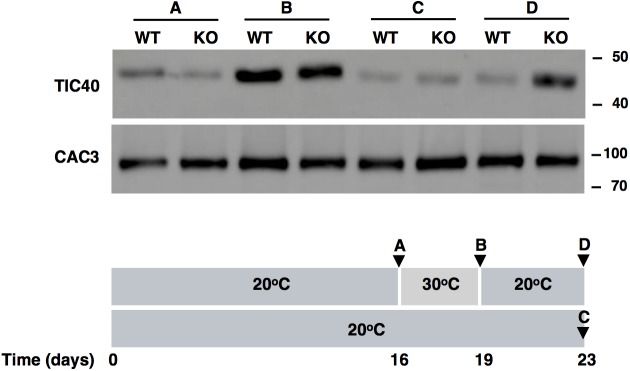
TIC40 is stabilized in the FTSH11 KO mutant upon recovery from heat. Two weeks old seedlings were grown at 20°C for additional 16 days, before being transferred to 30°C for 3 days and then returned to recovery at 20°C for 4 days. A control group was kept at 20°C for the entire duration of the experiment. At the time points indicated (A–D in the lower panel), samples were taken, total leaf extracts were made, and subjected to immunoblot analysis (upper panel) with the antibodies indicated in the left of the panel. Antibodies used are indicated on the left and migration of MW markers (in kDa) are indicated on the right of each blot.